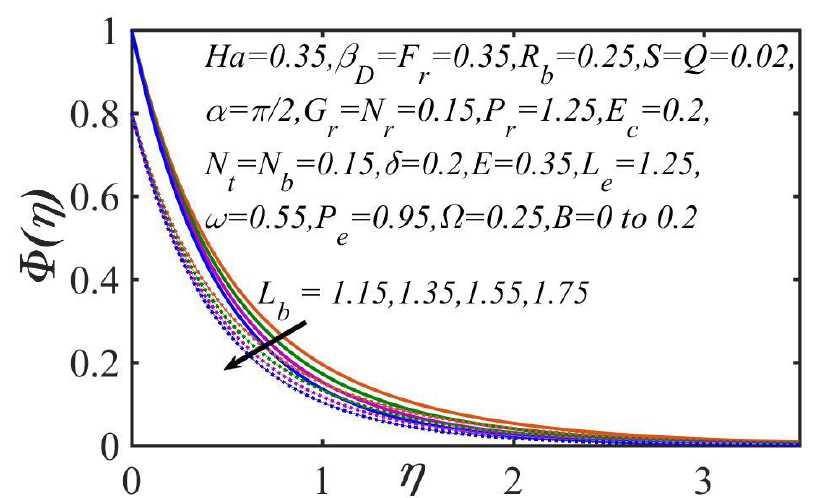
Figure 14. Influence of 𝐿 𝑏 and 𝐵 on the microorganisms ’ magnitudes. Solid curve: 𝐵 = 0 ; dotted curve: 𝐵 = 0.2 .